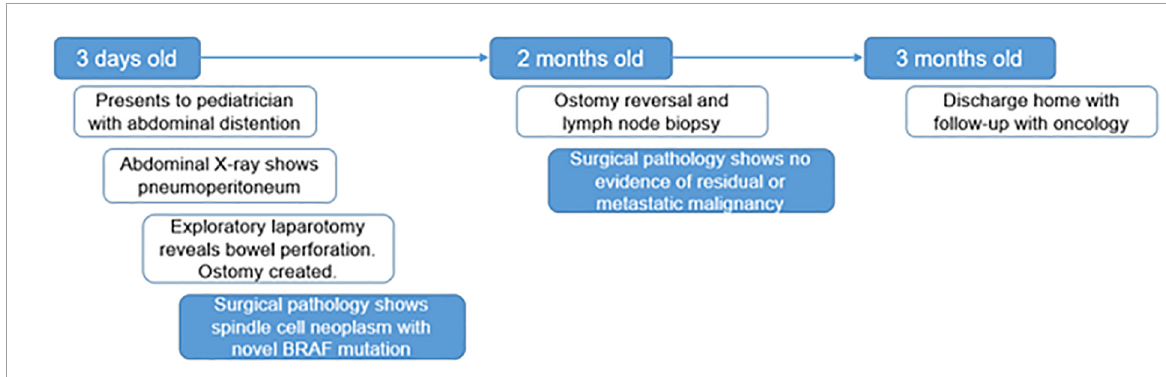
FIGURE1 Timeline. A graphic depiction of the timeline of events in this